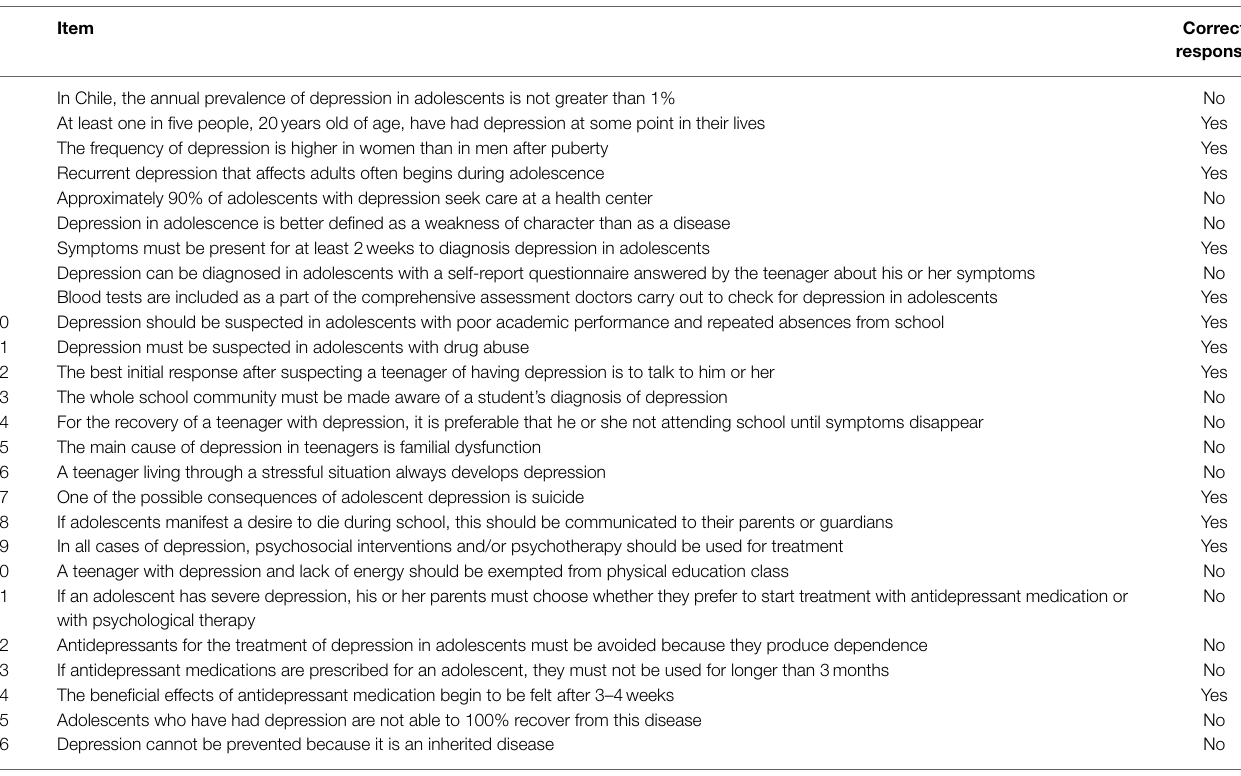
TABLE 1 | Knowledge Questionnaire of Adolescent Depression for School Staff